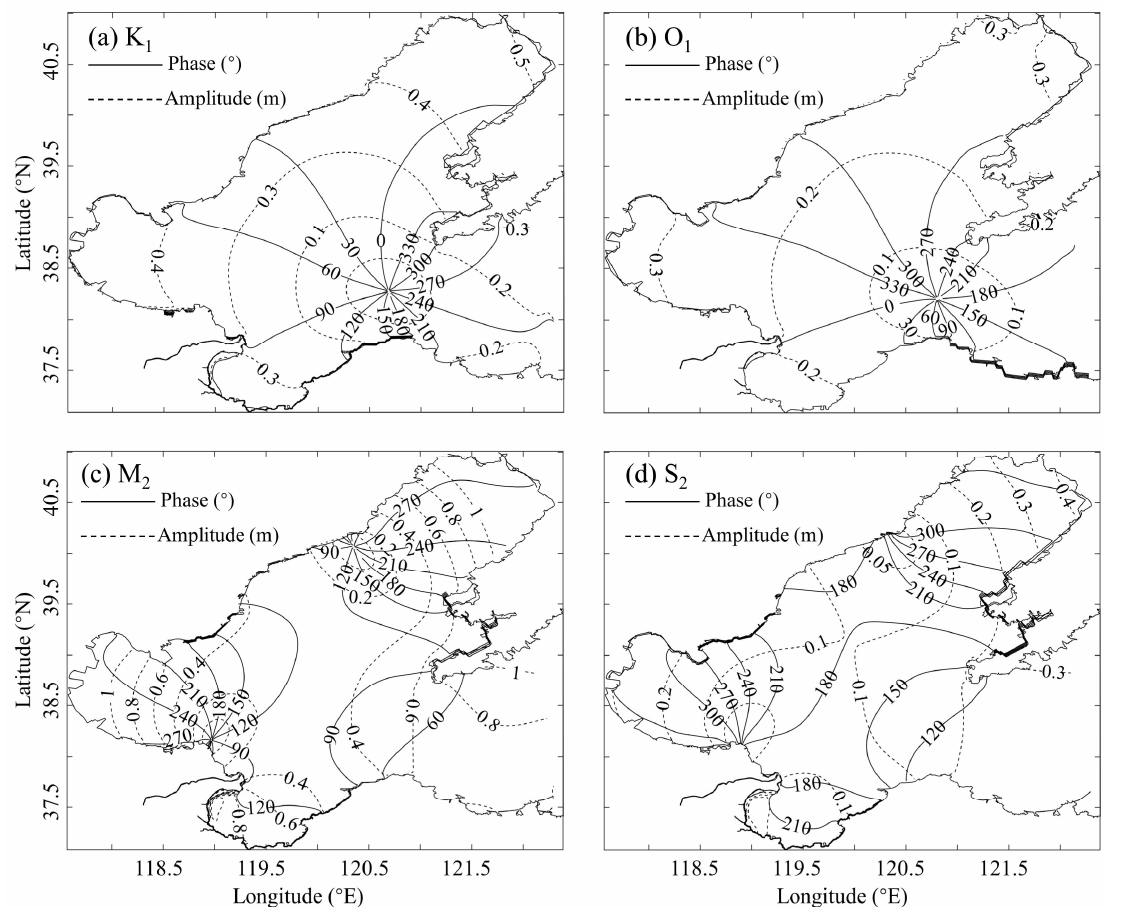
Figure 3. Co-tidal charts of ( a ) K 1 , ( b ) O 1 , ( c ) M 2 , and ( d ) S 2 tide constituents from the model simulations.